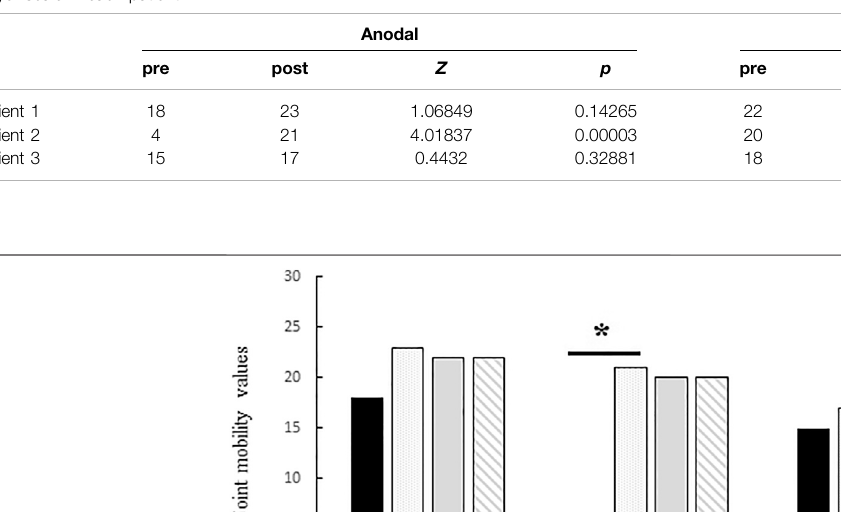
TABLE 3 | Percentage differences calculated for the pre- and post-anodal and sham stimulation conditions with regard to the spasticity improvement values of the Fugl- Meyer scale in each patient. Anodal